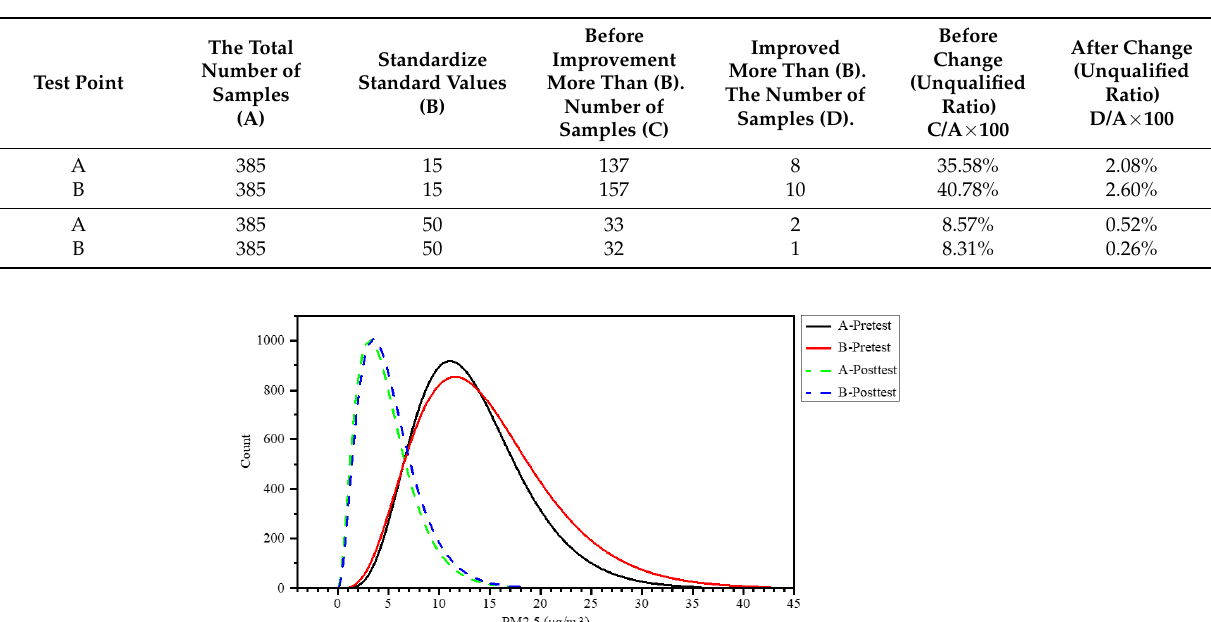
Table 4. Comparison of unqualified ratios before and after the implementation of the improvement plan.